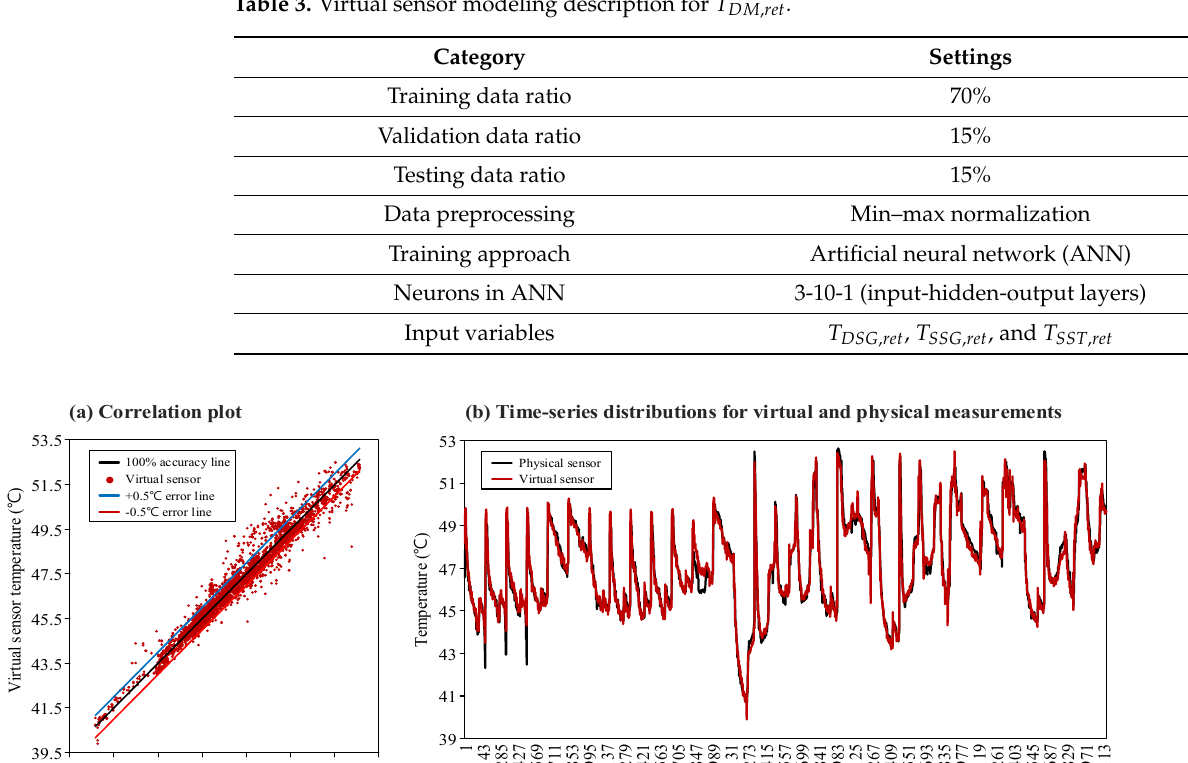
Table 2. Periods for training, testing, operation, calibration, and validation of the virtual sensor.